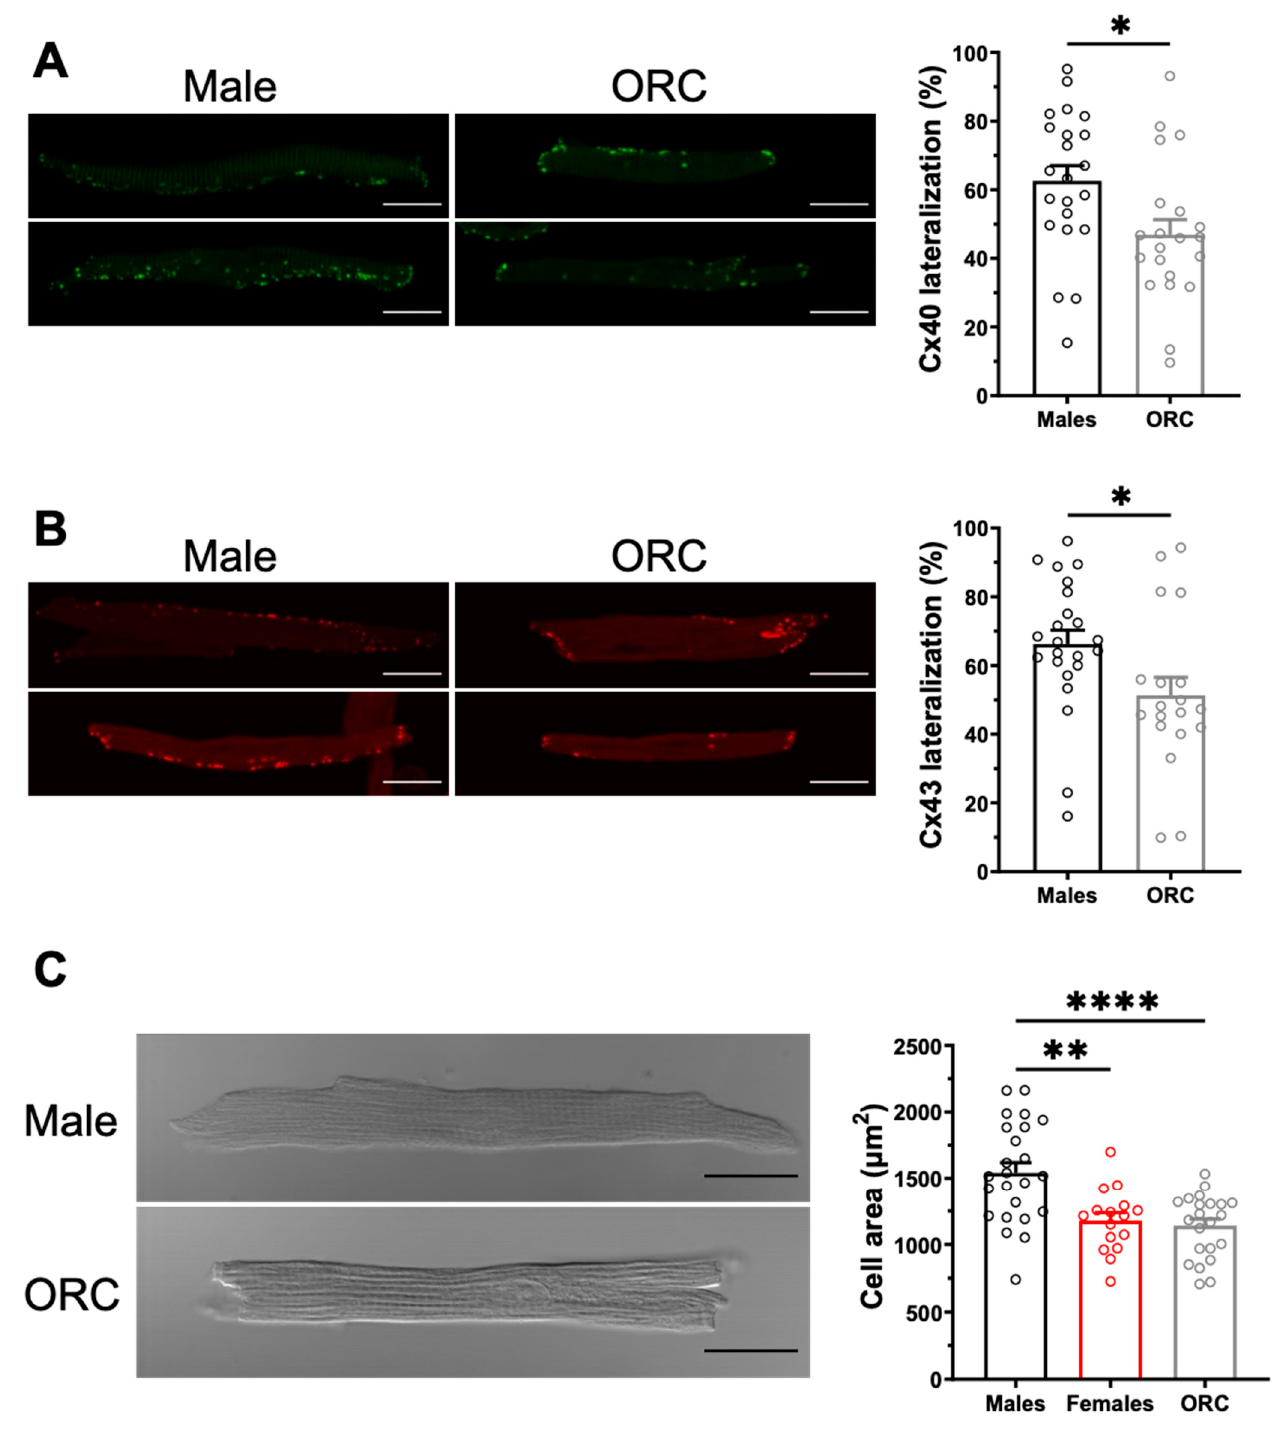
Figure 7. Orchiectomy reduces connexin lateralization and cell size in males. ( A , B ). Left. Representative examples of the distribution of Cx40 (in green, panel ( A )) and Cx43 (in red, panel ( C )) in male and ORC atrial myocytes. Right. Lateralization of Cx40 (panel ( A )) and Cx43 (panel ( B )) in left atrial myocytes is reduced by orchiectomy (ORC) compared to control males. ( C ). Left. Typical images of left atrial myocytes from male and ORC mice. Right. Scatter plot of cell area of male and ORC left atrial myocytes from connexin immunofluorescence experiments. Scale bars represent 20 µm. * p < 0.05, ** p < 0.01, **** p < 0.0001.